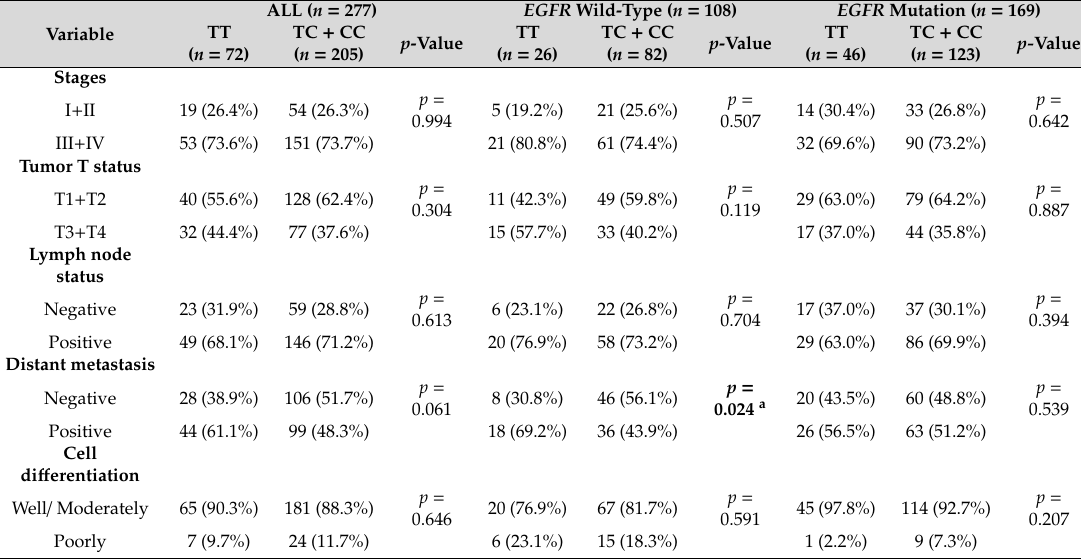
Table 3. Clinicopathologic characteristics of lung adenocarcinoma patients with EGFR mutation, stratified by polymorphic genotypes of FGFR4